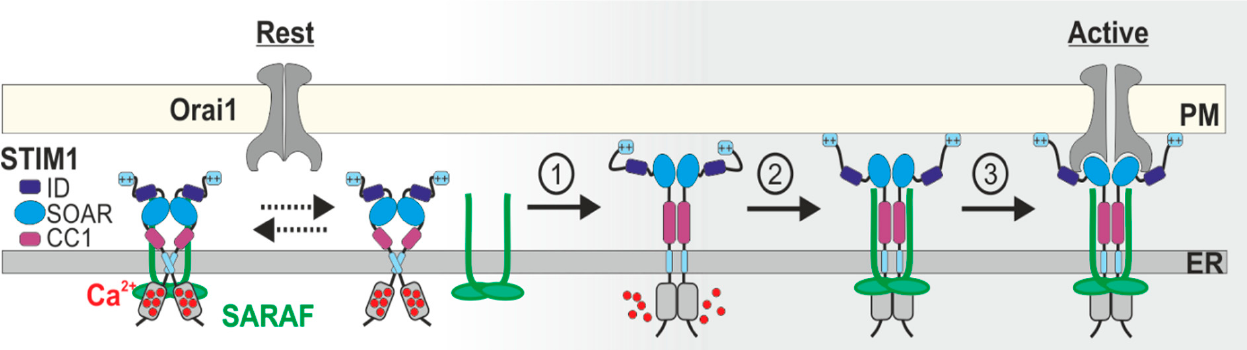
Figure 1. Interaction between the CRAC channel and SARAF during channel activation. Rectangle and oval symbols indicate the different domains of STIM1. At resting conditions, a fraction of SARAF (green) interacts with STIM1. Following ER Ca 2+ depletion (step #1), SARAF undergoes a transient disassociation from STIM1 but the interaction is quickly regained (step #2) and further augmented (step #3) following binding of STIM1 to Orai1.